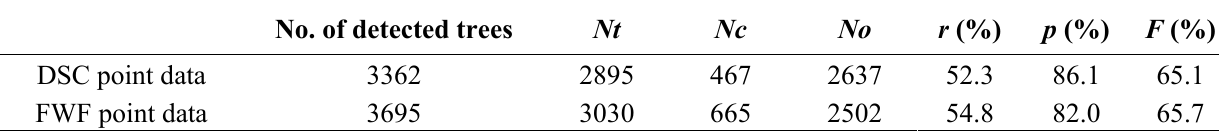
Table 3. Accuracy assessment for individual tree detection from DSC data and FWF data.